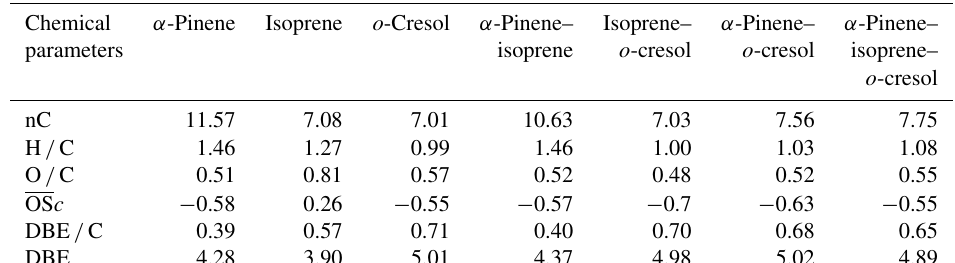
Table 3. Intensity-weighted average values from negative-ionization-mode LC-Orbitrap MS for O / C, H / C, OSc, DBE / C, DBE, and the number of carbons present (nC) for SOA filter extracts from single and mixed precursor experiments.